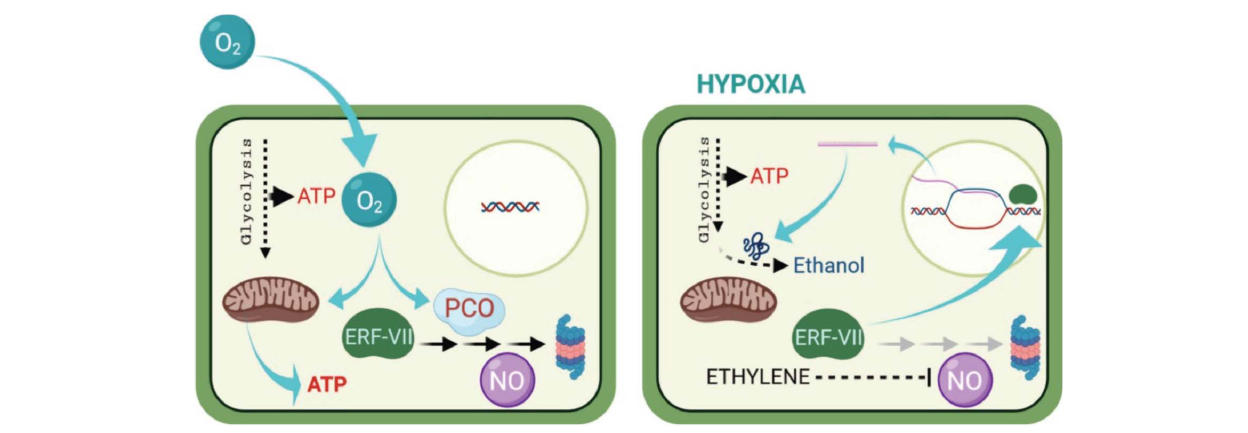
FIGURE 1 | How plants sense oxygen. Under aerobic conditions (left), aerobic respiration in the mitochondria provides most off the energy (ATP) required for the cell metabolism. The ERF—VIII transcription factor genes are constitutively expressed, but their stability is compromised by the activity pf PCOs. Which is a process requiring oxygen, oxidize the N-terminal Cys residue, channeling the ERF-VII proteins to the proteasome, in a process also requiring nitric oxide (NO). Under hypoxia (right), the respiration in the mitochondria is drastically reduced, and AT production can only occur because of enhanced glycolytic activity. The ERF-VII proteins are stabilized because of the absence of oxygen and also thank to ethylene production, which dampers the presence of NO in the cell. The stable ERF-VII proteins migrate to the nucleus where they activate the transcription of Hypoxia-Responsive Genes (HRGs), including genes encoding proteins required for the alcoholic fermentation. (From Loreti and Perata, 2020, published under an open access Creative Common CC BY